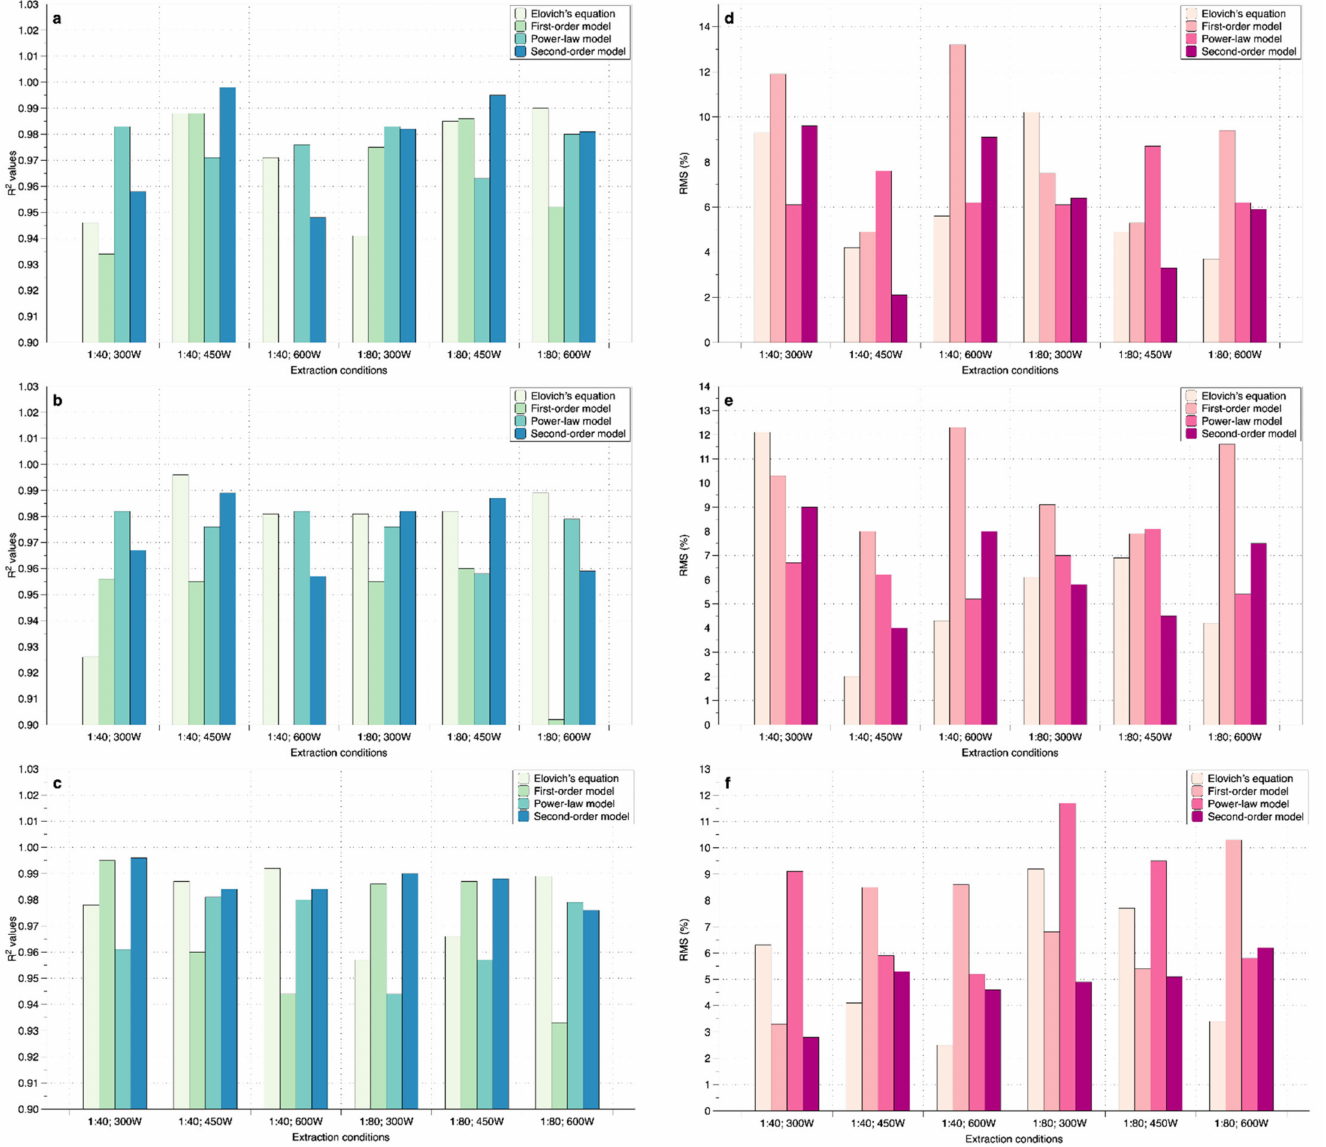
Figure 2. Comparison of model statistical parameters for MAE of P. fruticosa leaves: R 2 value (chlorophyll a ( a ); chlorophyll b ( b ), antioxidant activity ( c )); RMSE ((chlorophyll a ( d ); chlorophyll b ( e ), antioxidant activity ( f